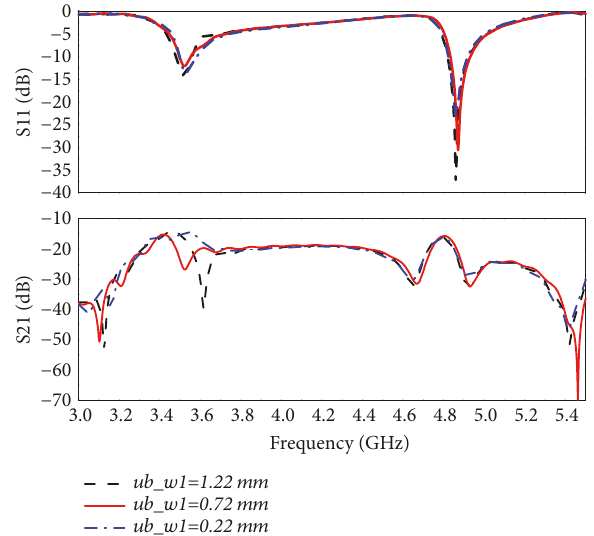
Figure 6: S-parameters of different distance between larger